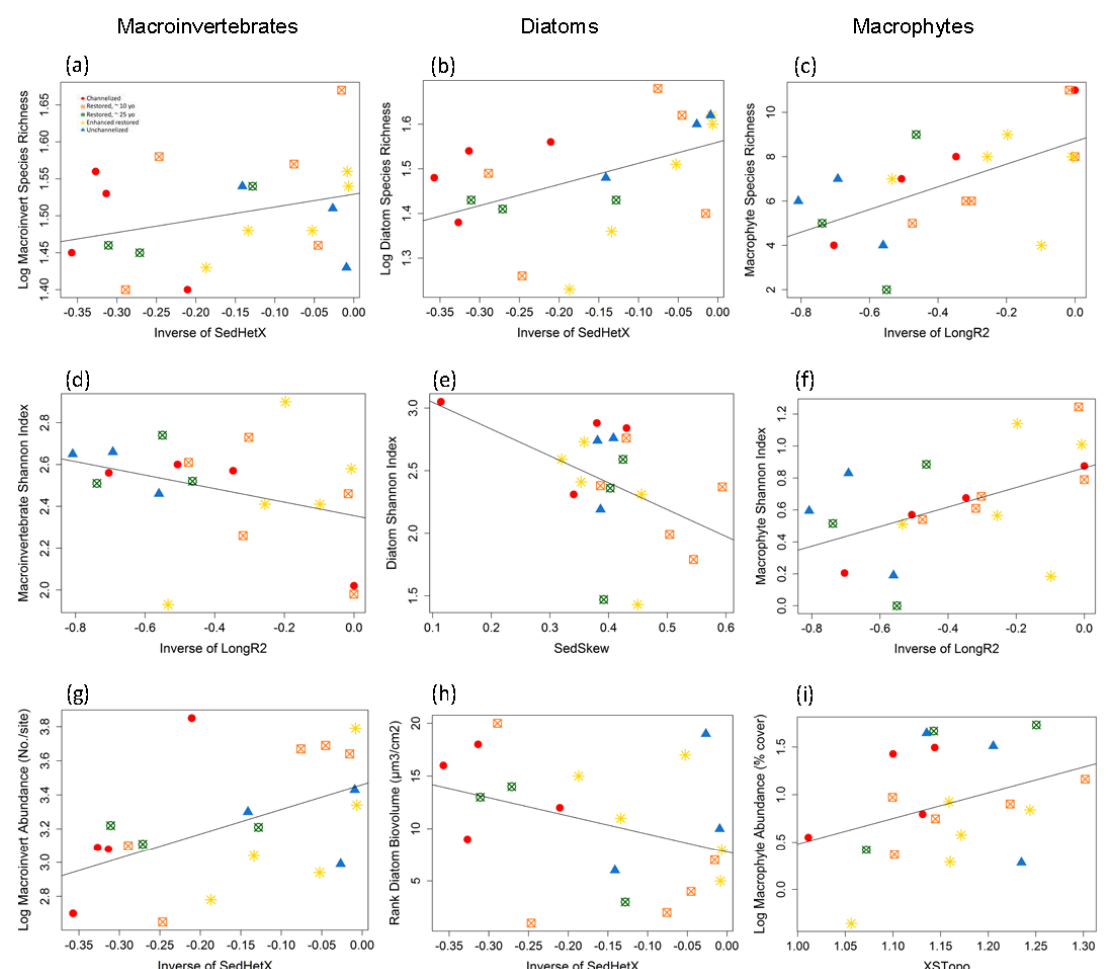
Figure 3. Linear regressions of the most important geomorphic complexity metrics explaining variation in species richness (top row), Shannon diversity index (middle row), and abundance (bottom row) of macroinvertebrates (left column), diatoms (middle column), and macrophytes (right column). Geomorphic complexity always increases from left to right on the x-axis; because SedHetX and LongR2 become more complex at lower values, these values are inverted here to make interpretation easier. Different symbols and colors represent each restoration status. LongR2 was power transformed before analysis, other axes describe transformations of data (typically log). See Table 1 for explanations of complexity codes.